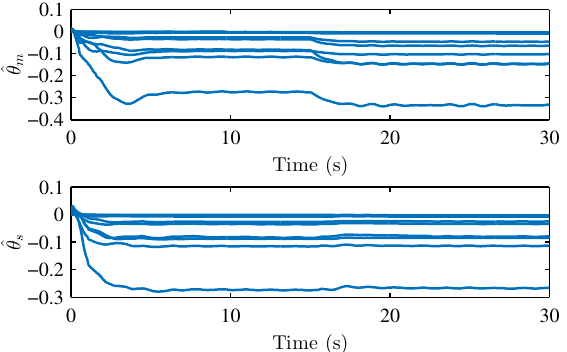
Figure 6. Adaptive parameters θ m and θ s in RBF neural network for uncertain parts